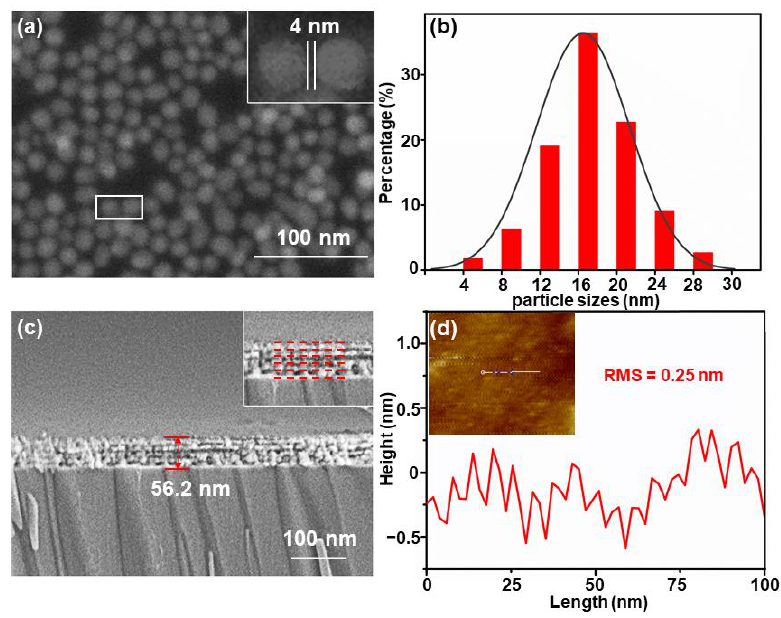
Figure 2. ( a ). SEM image of the Au-nanoparticle (NP) layer after drying naturally. ( b ) The distri- bution of the diameters of the Au NPs. ( c ) Cross-sectional SEM image of five-Au/Al 2 O 3 -bilayer structure. The inset shows a local-magnification image. ( d ) The root-mean-square (RMS) roughness of the Al film can be seen from the white line drawn in the